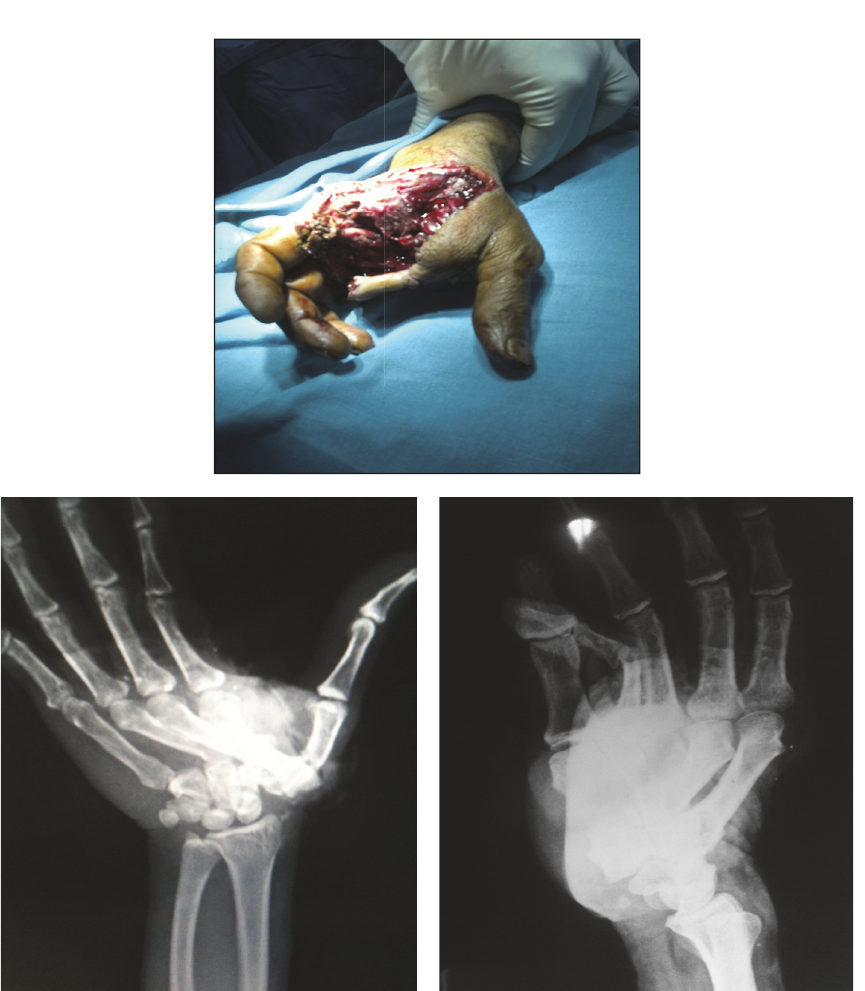
Figure 1: Clinical picture and X-ray at the time of injury.